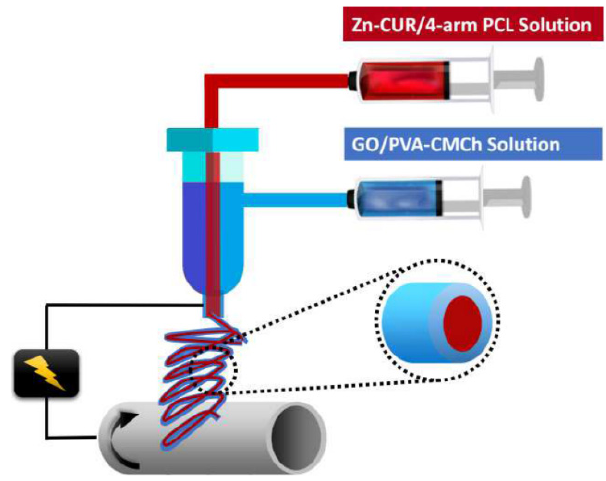
Fig. 6. Electrospinning process of containing core – shell nano¯bers.